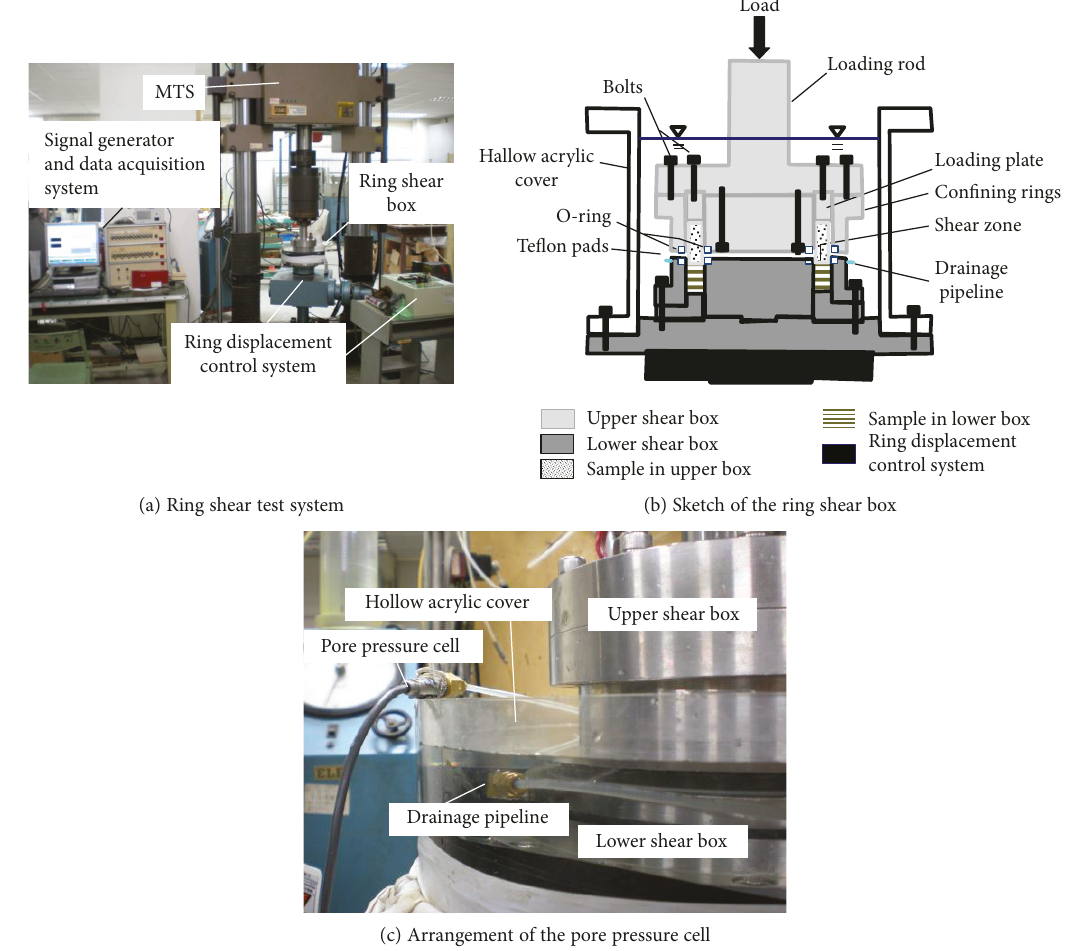
Figure 3: New pore pressure monitoring ring shear test apparatus.